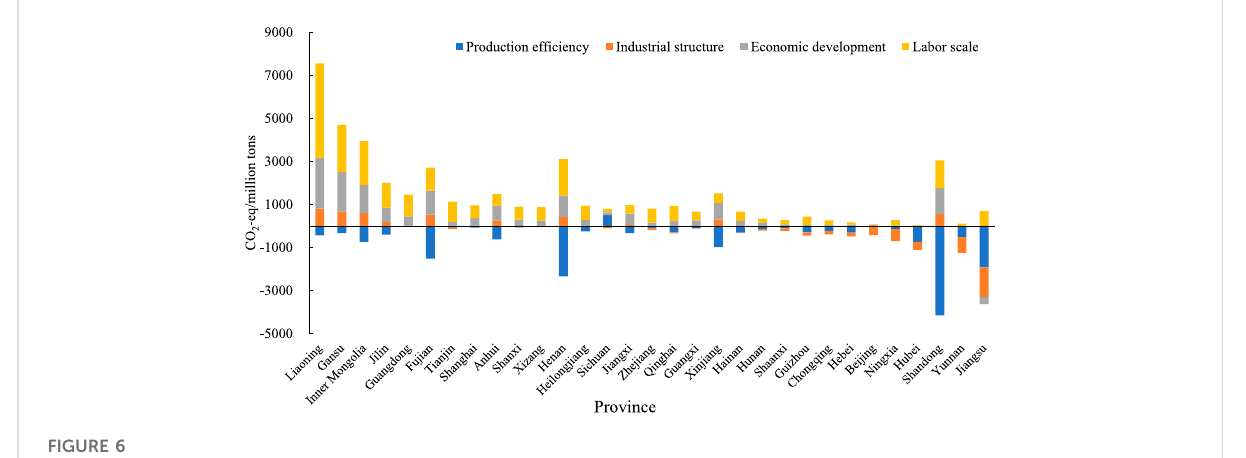
FIGURE 6 Factors driving GHG emissions from livestock in the CAGDMZ of each